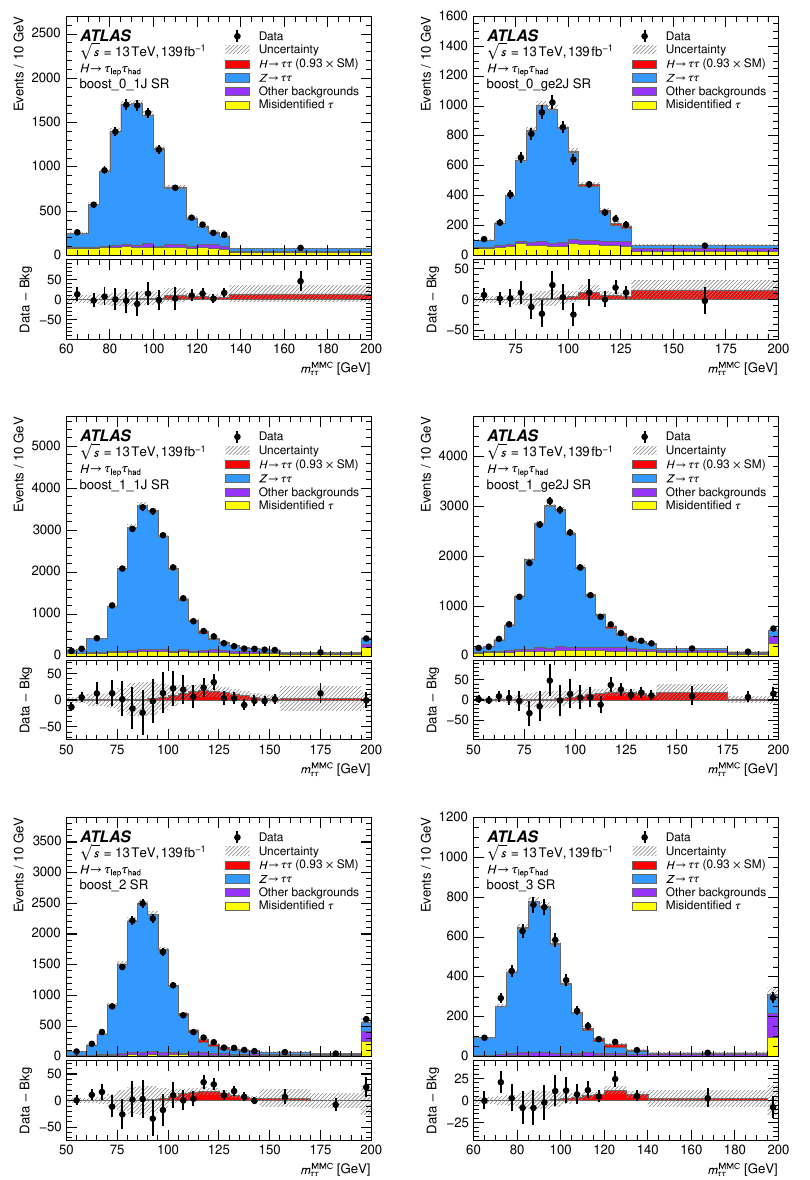
Figure 18. Distribution of the reconstructed ττ invariant mass ( m MMC ) for all events in the boost ττ categories of the τ τ channel. The bottom panel shows the differences between the numbers of lep had observed data events and expected background events (black points). The observed Higgs boson signal, corresponding to ( σ × B ) / ( σ × B ) = 0 . 93 , is shown with a filled red histogram. Entries SM with values above the x -axis range are shown in the last bin of each distributions. The dashed band indicates the total uncertainty on the total predicted yields. The prediction for each sample is determined from the likelihood fit performed to measure the pp → H → ττ